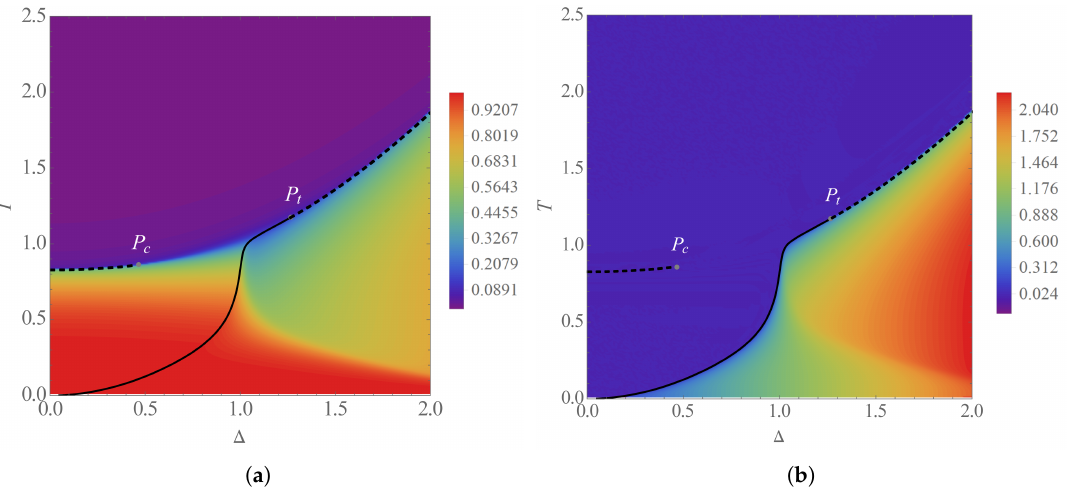
Figure 3. Phase diagram at a field H = 0.15, with the choice { χ 1 , χ 2 , χ 3 } = { 1,0,0 } , in the T × ∆ plane. The color code shows the behavior of ( a ) the uniaxial order parameter S , which is always nonzero in the paranematic phase, which extends up to high temperatures, and ( b ) the biaxial order parameter η , which is nonzero only in the biaxial phase, which now extends to intermediate temperatures when ∆ > 1. Notice that both S and η present a steep but nonsingular behavior in the region corresponding, at zero field, to the continuous transition between the biaxial and the discotic uniaxial